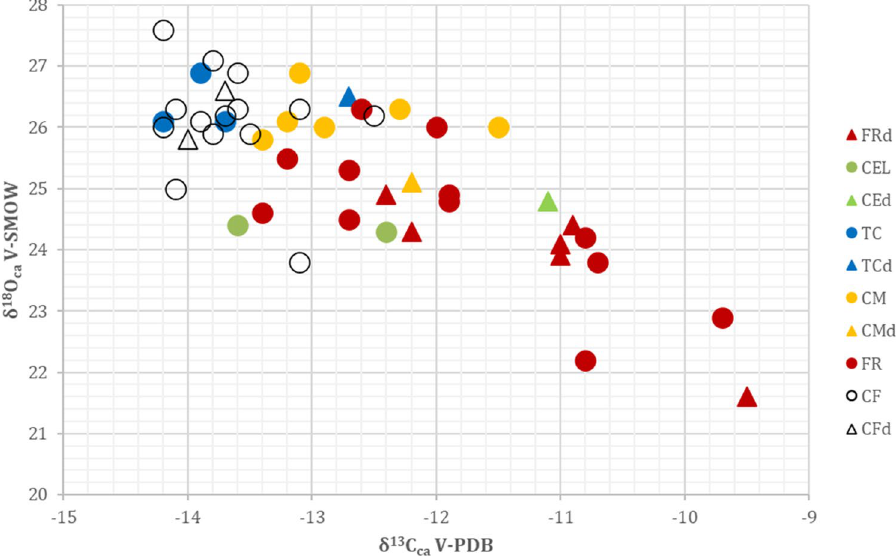
Figure 3. Bivariate plot of oxygen and carbon isotope values for deciduous and permanent teeth. Samples coming from different locations are indicated with different colors. Dots = Permanent teeth, Triangle = Deciduous teeth. FR = Fontenoce di Recanati; CM = Casetta Mistici, CF = Osteria del Curato-Via Cinquefrondi; TC = Torre della Chiesaccia,CE = Celano